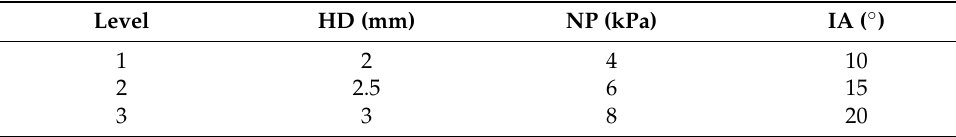
Table 2. Factors